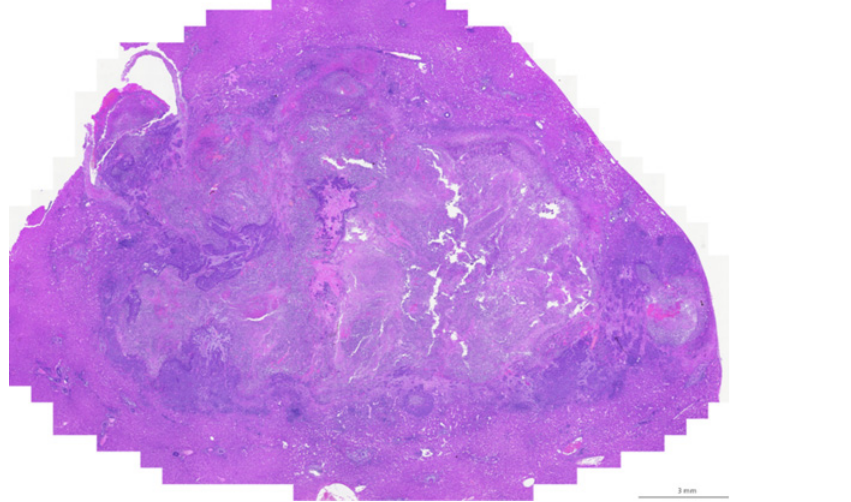
Fig 4. Histology. H&E staining was performed confirming tumors within the liver.